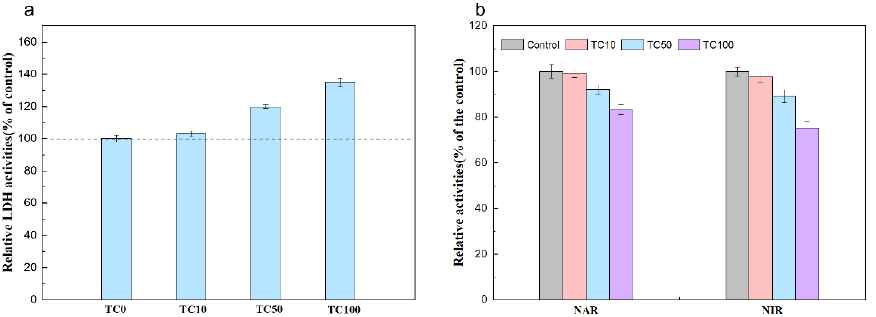
Figure 5. Effect of TC exposure on ( a ) relative LDH release level and ( b ) key enzymes related to denitrification.